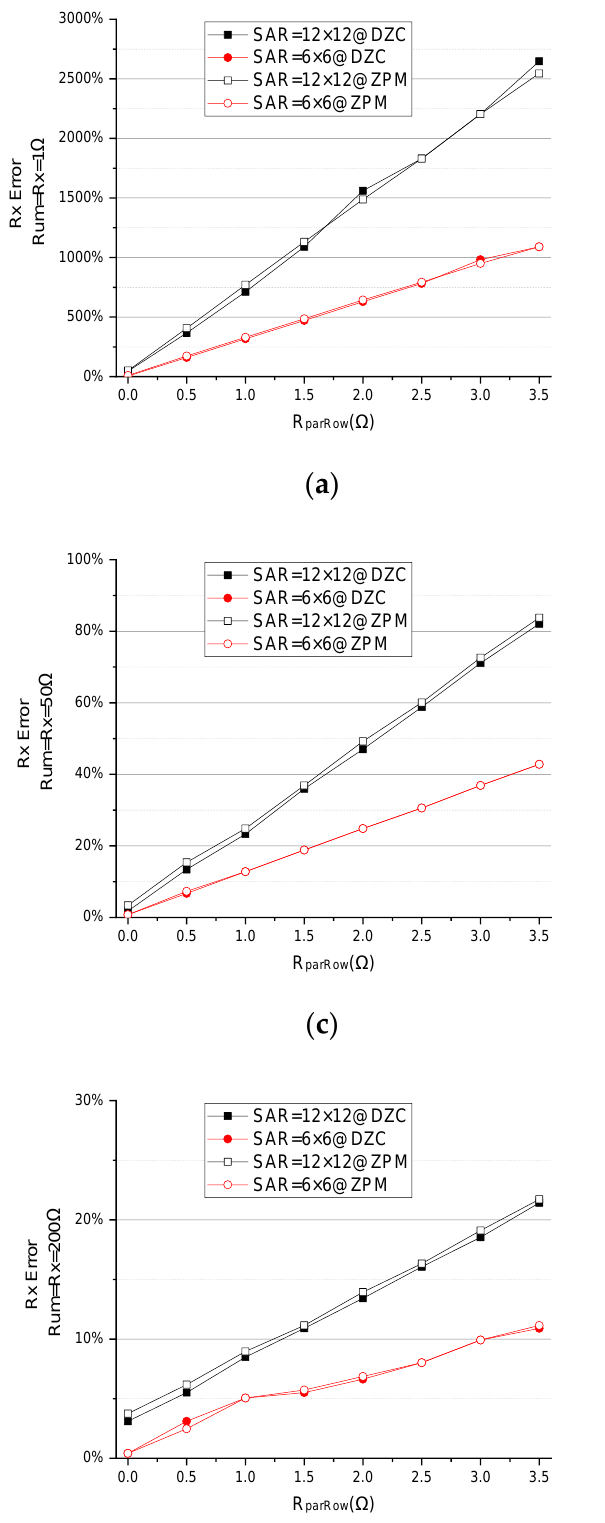
𝑅 𝑝𝑎𝑟𝑅𝑜𝑤 and ( b , d , f ) effect of 𝑝𝑎𝑟𝐶𝑜𝑙 in DZCM and ZPM